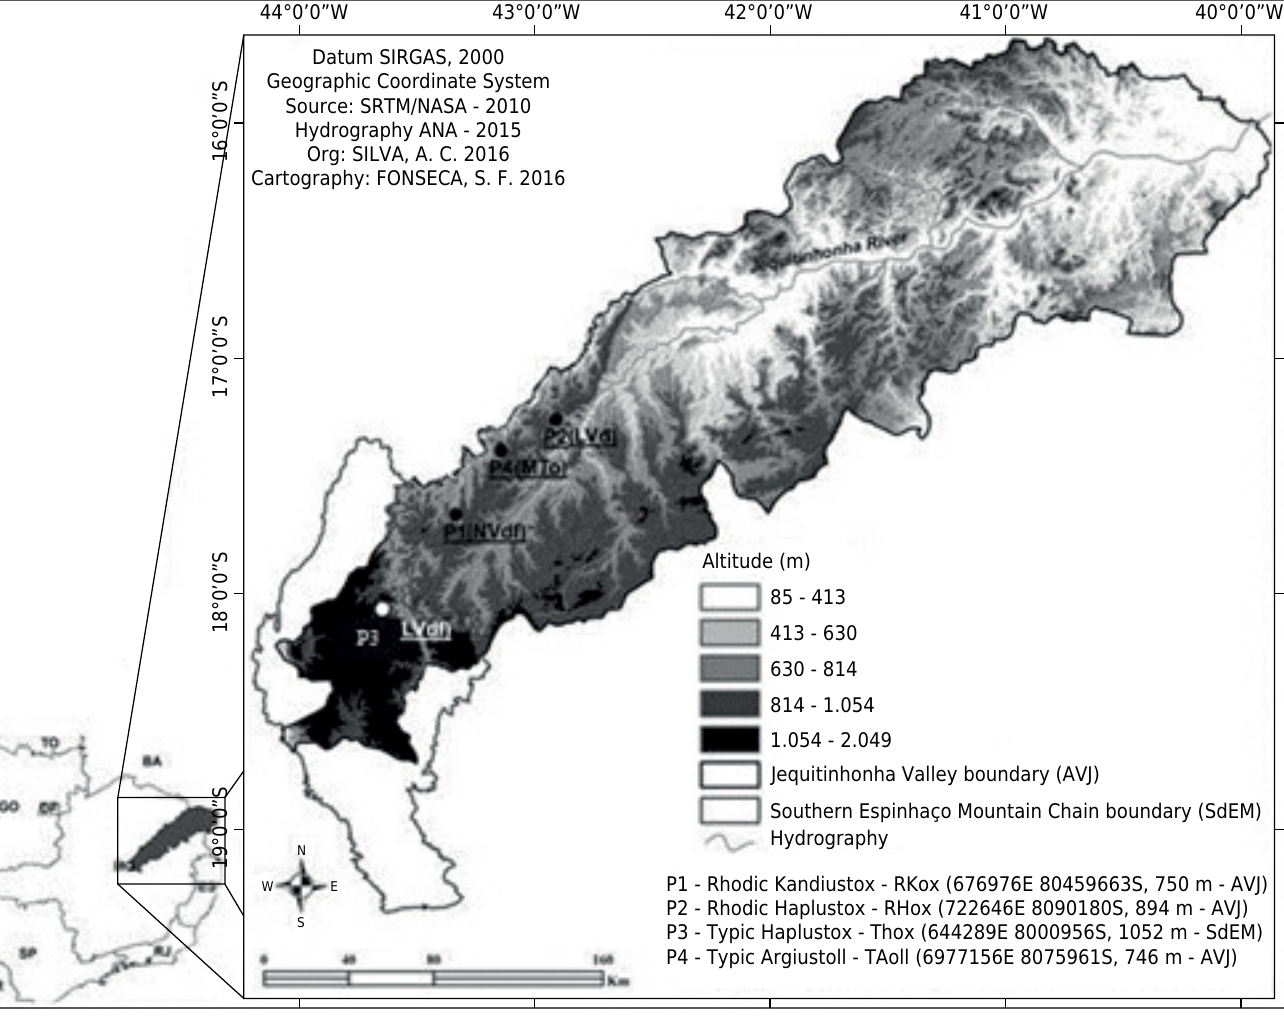
Figure 1. Geographical map identifying the sampling sites in the Southern Espinhaço Mountain Chain and Upper Jequitinhonha